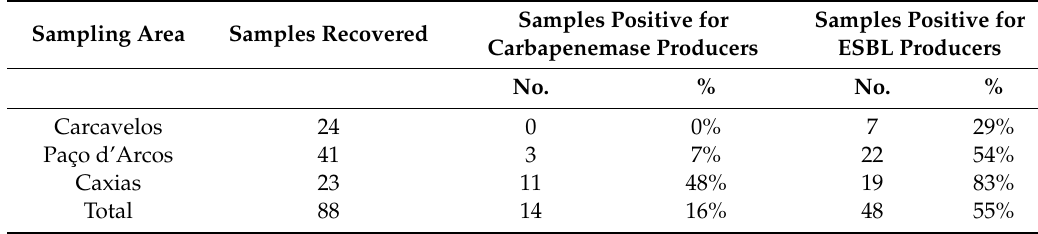
Table 1. Samples recovered, and samples in which carbapenemase or ESBL producers were recovered. Sampling Area Samples Recovered